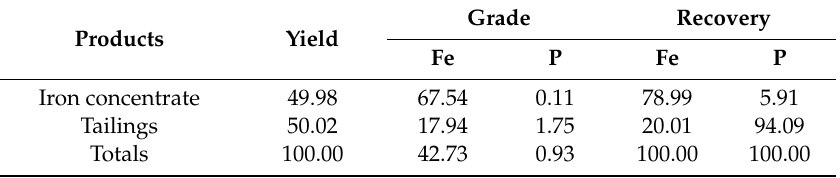
Table 4. Test results for low-intensity magnetic separation–reverse flotation process (%).